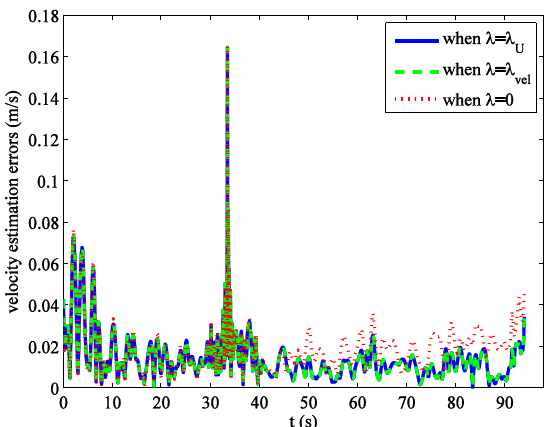
Figure 6. Errors of velocity estimates versus time when λ = λ U , λ vel , and 0.